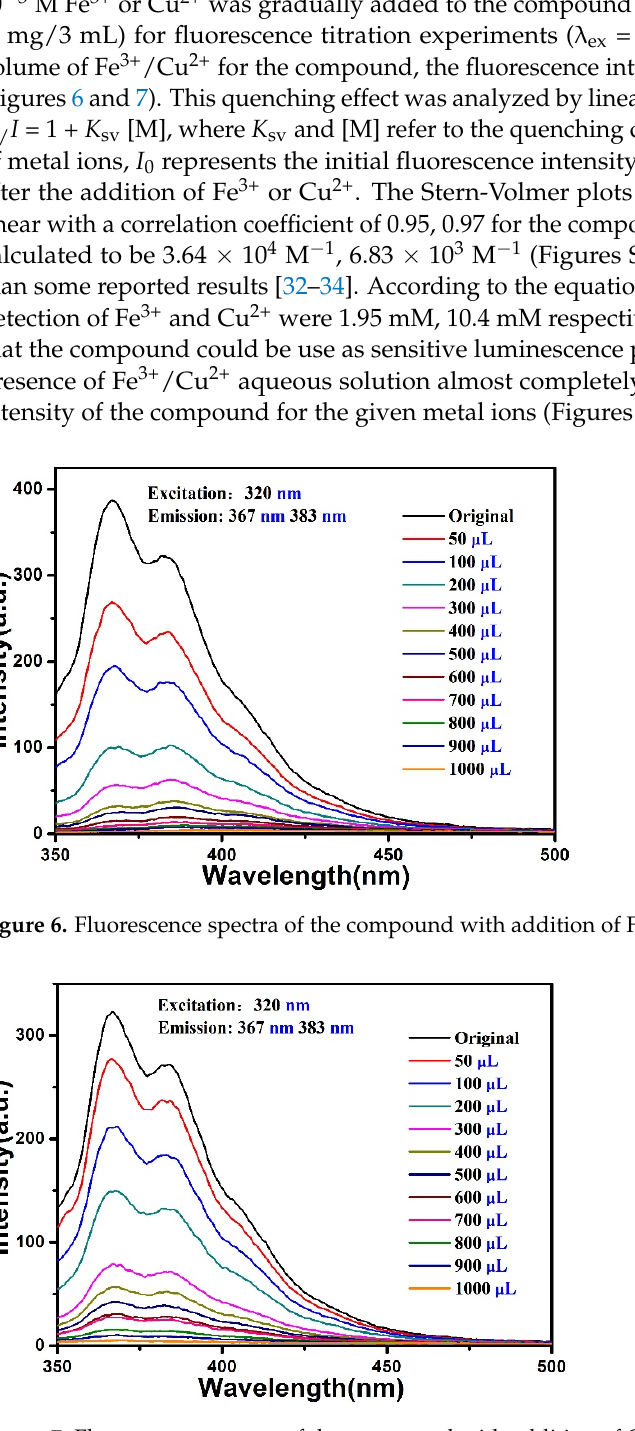
Figure 5. Fluorescence spectra of the compound towards different metal ions.